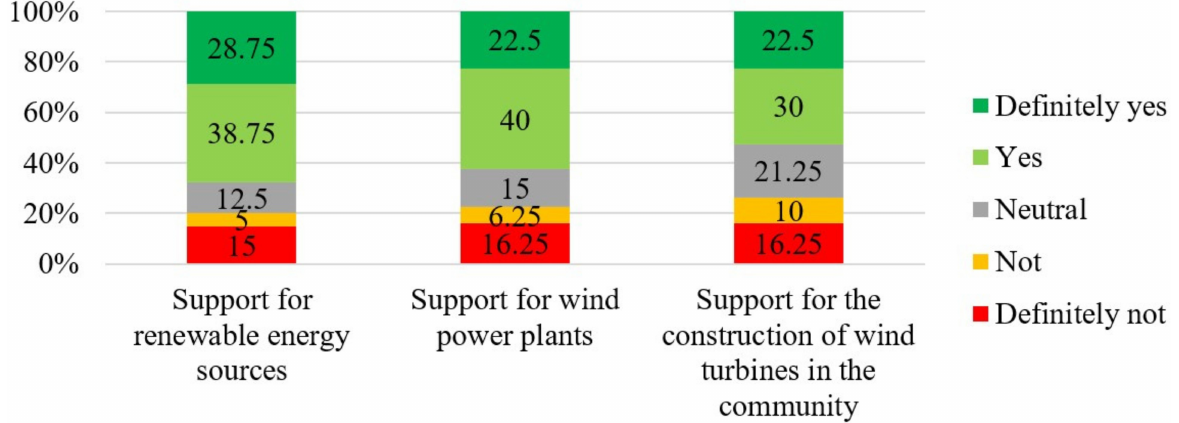
Figure 1. Support for the development of renewable energy technologies, siting of wind farms, construction of a wind farm in the municipality in which the respondents live (%). Source: based on own